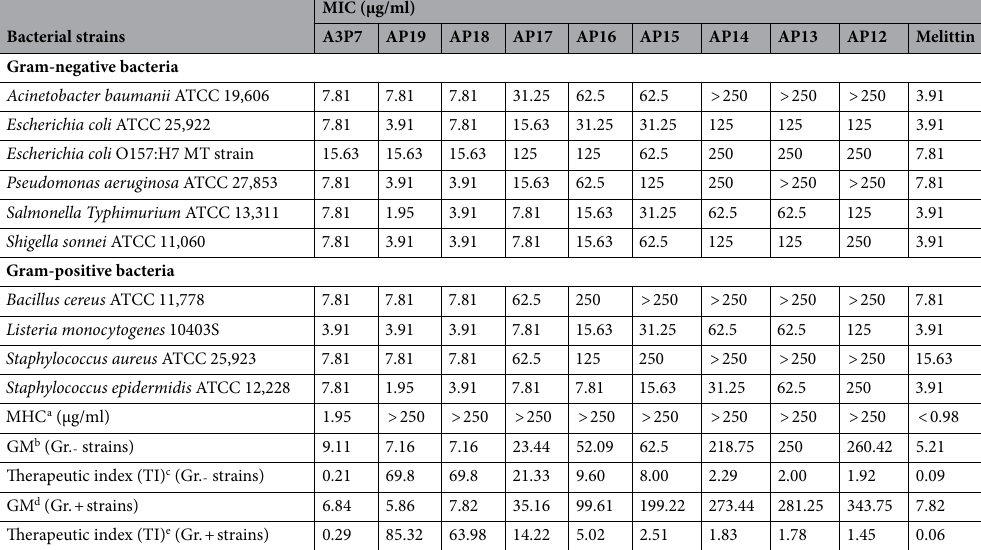
(Table 2), AP19 had the greatest antimicrobial activity against both Gram-negative and -positive bacteria (had the lowest GM values). The hemolytic activity of peptides against fresh hRBCs was determined at various concentrations (0.98 to 250 µg/ml) to indicate their toxicity on mammalian cells (Fig. 1). Melittin, the positive control, completely lysed hRBCs at a concentration of 3.91 µg/ml. The parent peptide (A3P7) had obvious hemolytic effects displayed in a concentration-dependent manner. Of truncated peptides, AP12 to AP19 showed a marked decrease in hemo- lytic effects on hRBCs at all concentrations, with MHC (minimum concentration that causes 10% hemolysis) greater than 250 µg/mL. These results highlighted an advantage of truncation, a significantly reduced toxicity of the peptides. The therapeutic index (TI) is an important parameter to identify a candidate peptide, reflecting a balance between efficacy and safety 30 . It was calculated as the MHC value divided by GM value (Table 2) 23 . For Gram-negative bacteria, AP18 and AP19 exhibited the highest TI values of the designed peptides. For Gram- positive bacteria, AP19 showed the highest TI value. The TI value of AP19 against Gram-negative and -positive bacteria was 332 and 294 times higher, respectively, than that of A3P7 parent peptide.